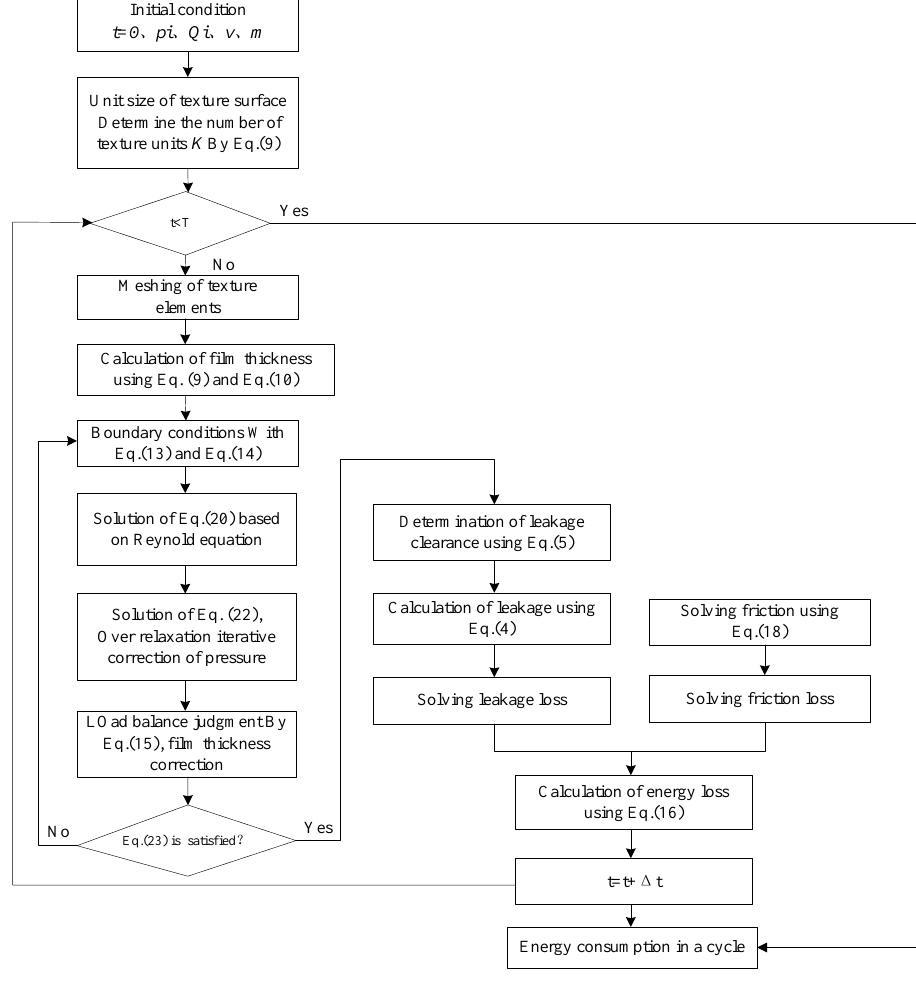
Figure 5. Flow chart for solving energy consumption loss.